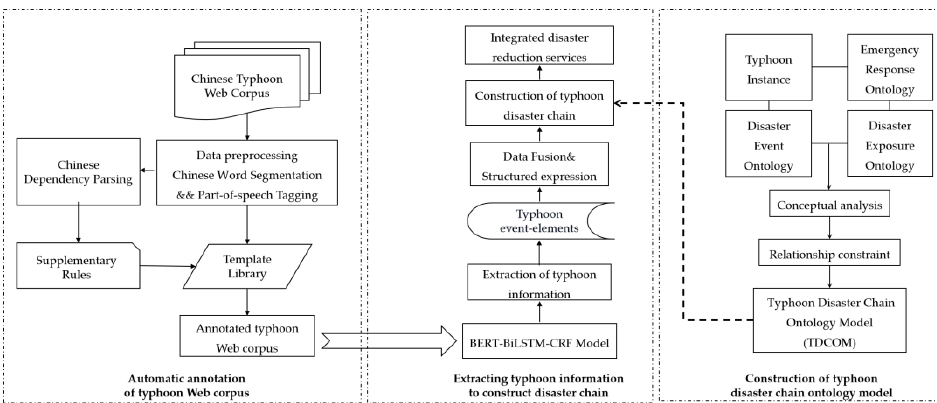
Figure 1. Construction of typhoon disaster chain based on Chinese Web corpus.